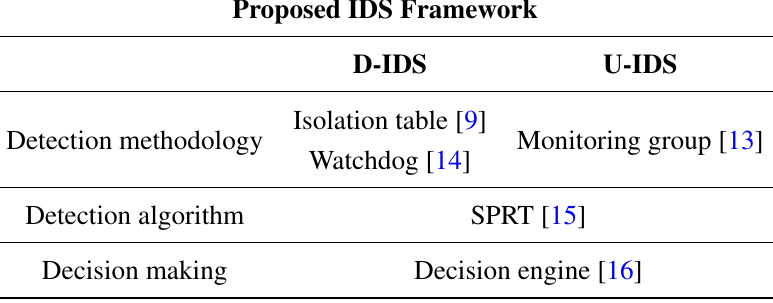
Table 1. Our proposed IDS framework for